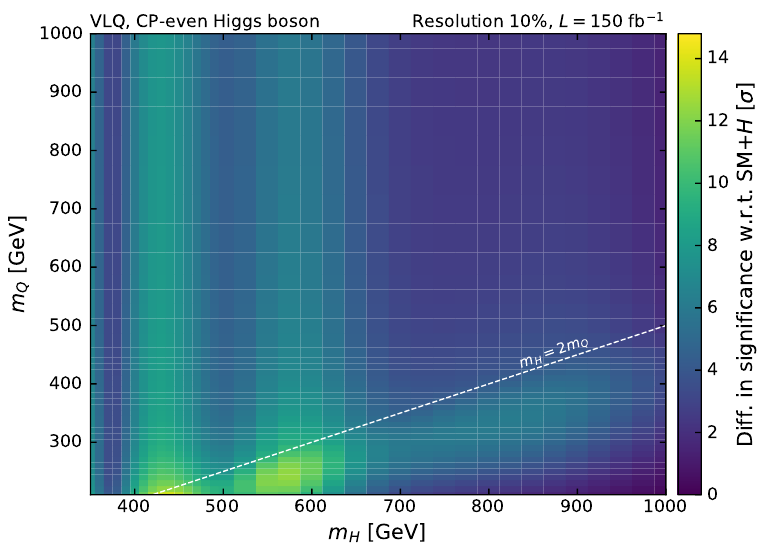
Figure 18 . The di(cid:11)erence in expected signi(cid:12)cance between the models with and without the contribution of VLQ to the Ht (cid:22) t form-factor, computed for a CP-even heavy scalar Higgs boson with ^ g = ^ g = 1 and N Q = 1. Below the dashed line, decays H ! Q (cid:22) Q are kinematically Ht (cid:22) t HQ (cid:22) Q